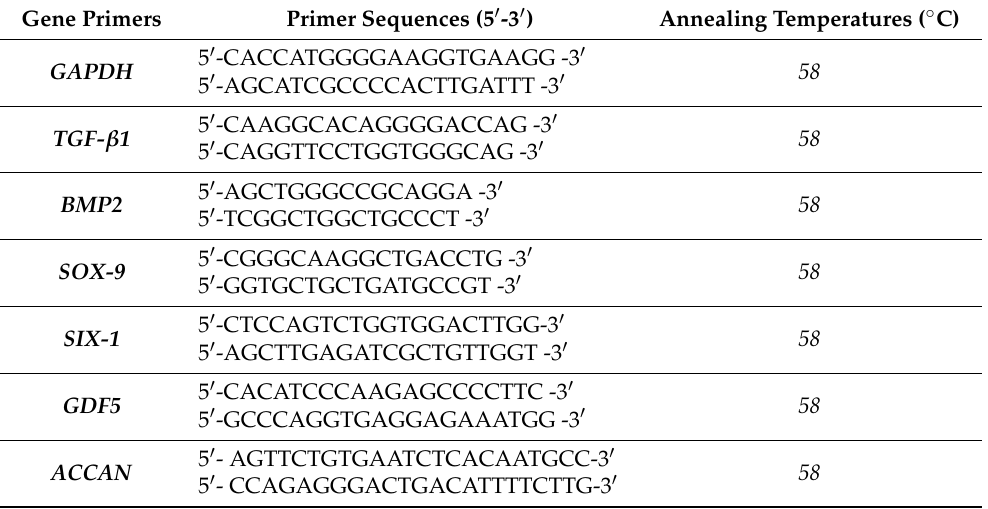
Table 1. Primer sequences and annealing temperatures.